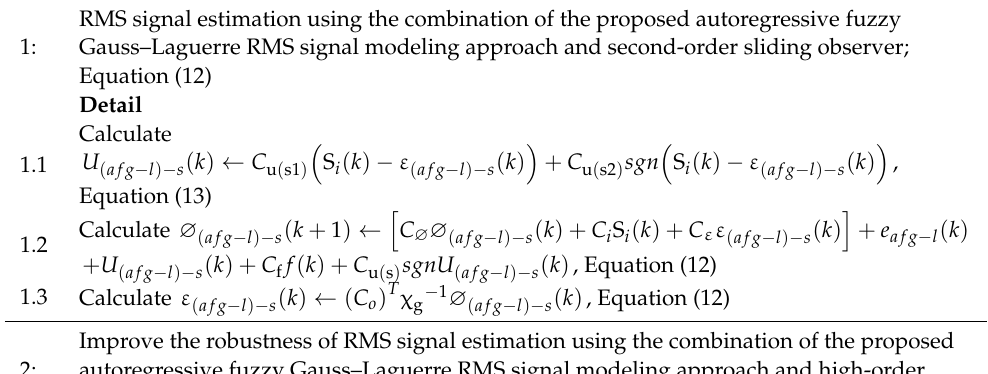
Algorithm 2: Proposed smooth sliding digital twin